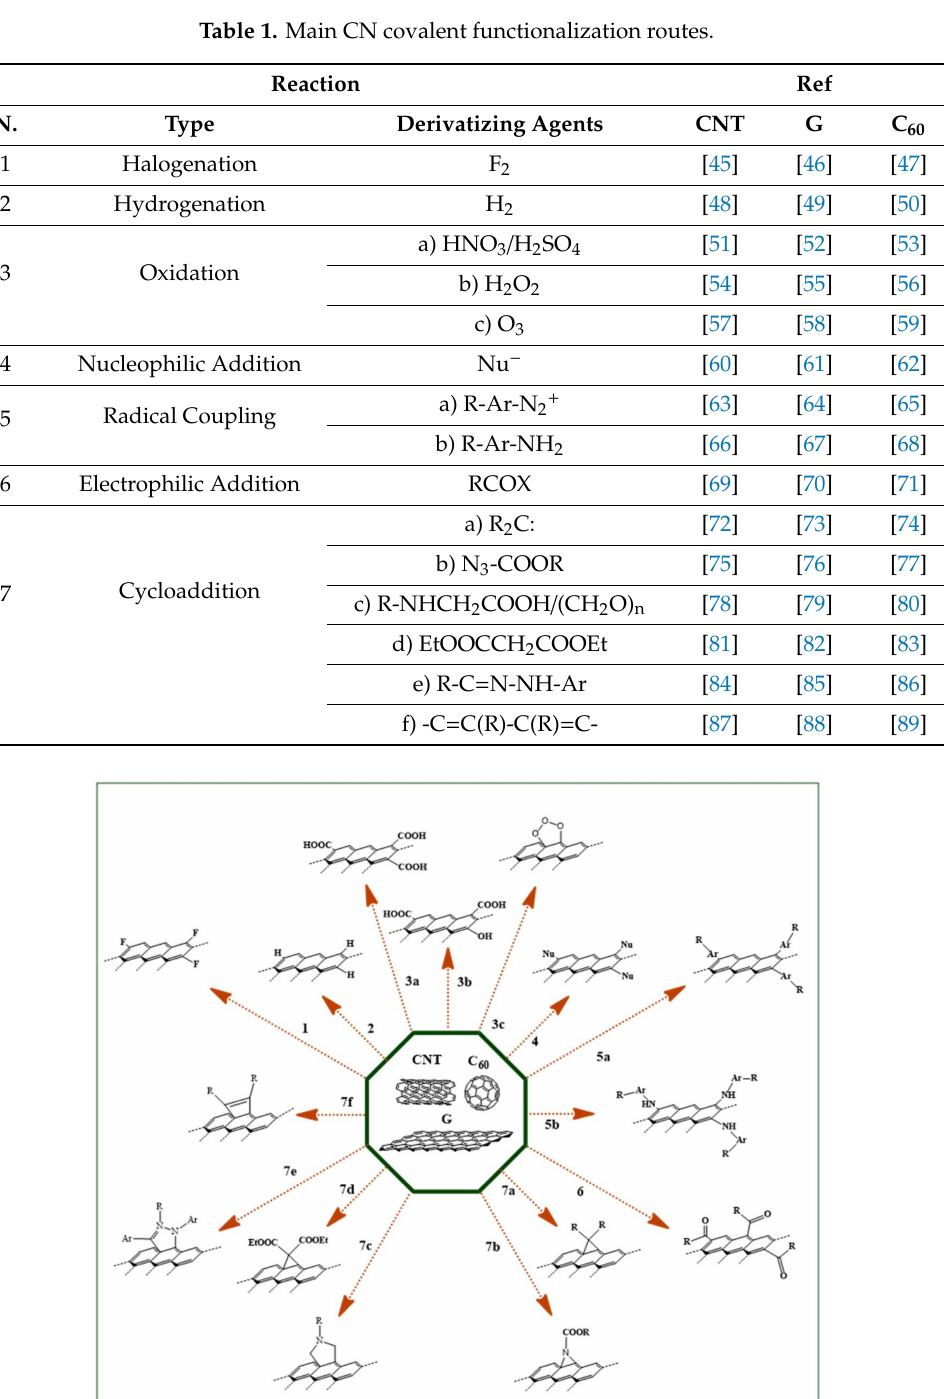
Figure 2. Schematic representation of the main carbon nanostructures covalent functionalization routes. CNT: carbon nanotubes; G: graphene; F: fullerenes. For each reaction, number codes and derivatizing agents are reported in Table